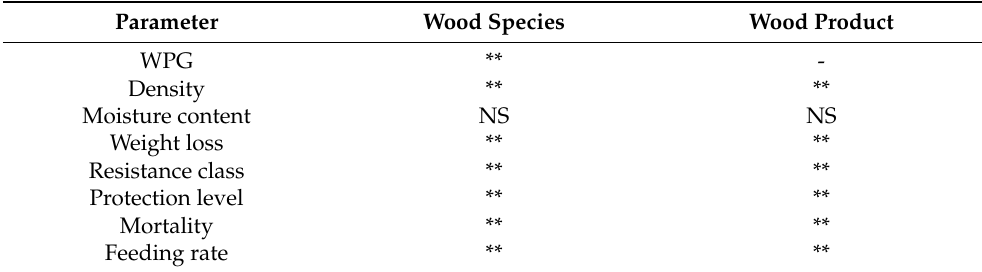
Table 4. Variance analysis of physical properties and laboratory termite test.